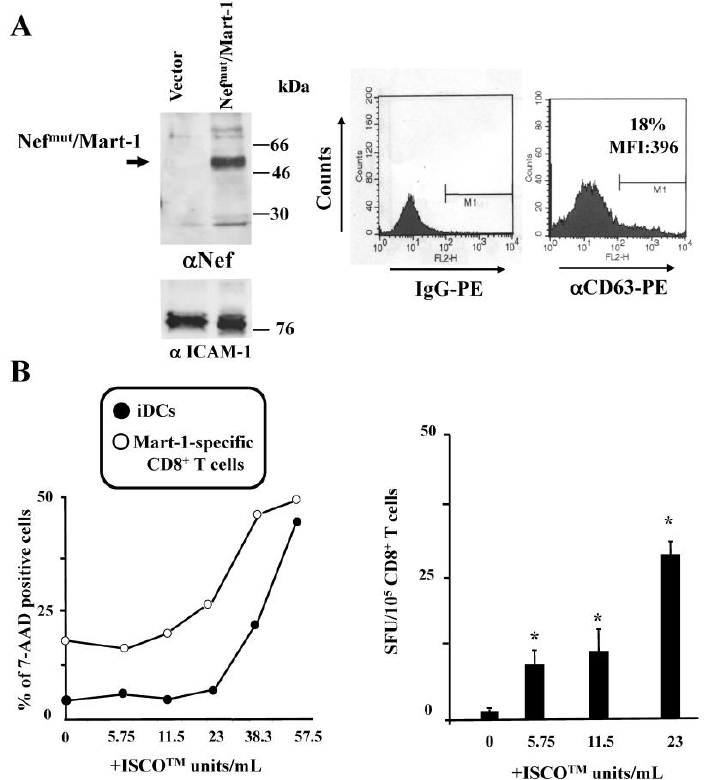
Figure 4. ISCOMATRIX TM adjuvant increases the cross-presentation of antigens delivered by engineered exosomes in iDCs. ( A ) molecular characterization of exosome preparations uploading Nef mu /Mart-1. On the left is the Western blot analysis of 200 µU of exosomes associating with Nef mut . As a control, equivalent amounts of exosomes from cells transfected with the empty vector were loaded. Arrow signs indicate the relevant protein product. Exosome preparations were also probed for the presence of ICAM-1. Molecular markers are given in kDa. On the right, the FACS analysis for presence of CD63 in exosome membrane is shown. M1 marks the range of fluorescence positivity as determined by the analysis of equivalent amounts of exosomes after incubation with isotype-specific IgGs ( left histogram). Both percentages and MFI of fluorescent beads are indicated. Results shown in both panels are representative of two assays carried out on two exosome preparations; ( B ) on the left is cell viability of both iDCs and Mart-1-specific CD8 + T cells treated for 24 h with the indicated concentrations of ISCOMATRIX TM adjuvant as evaluated by FACS analysis after 7-AAD labeling. Mean values from two independent experiments with duplicates are shown. On the right, results from cross-presentation analysis of Mart-1delivered by Nef mut /Mart-1 exosomes in HLA-A.02 iDCs are presented. A total of 10 5 cells were challenged with 100 µU of the exosomes and then cultivated for 5 h in the presence of the indicated doses of ISCOMATRIX TM adjuvant. Thereafter, the cells were put in co-culture overnight with a Mart-1-specific, HLA-A.02 restricted CD8 + T cell line in IFN-γ Elispot microwells. The mean + SD number of SFU/10 5 cells calculated from three independent experiments are shown. * p < 0.05.